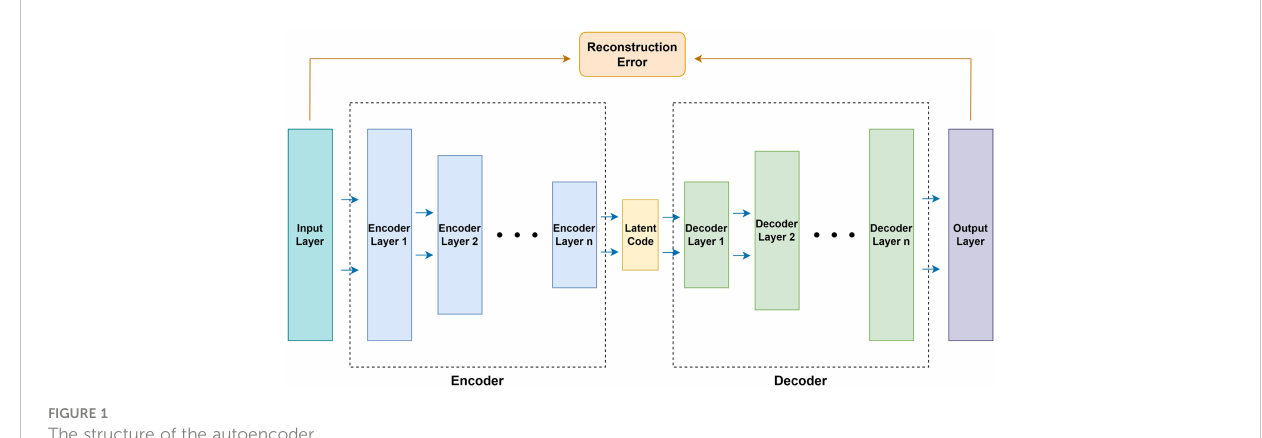
FIGURE 1 The structure of the